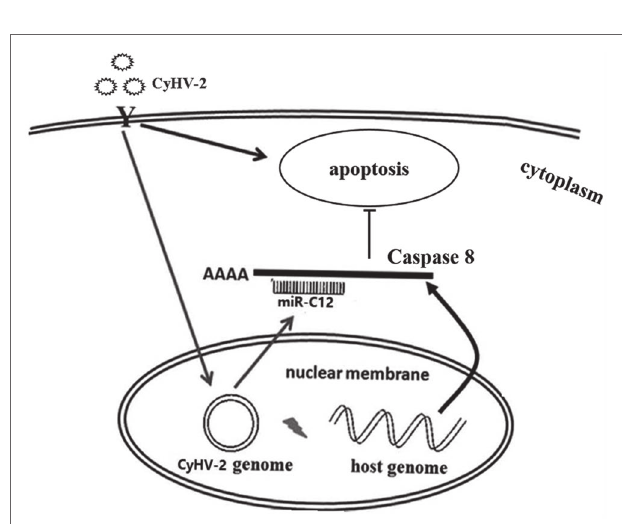
FIGURE 7 | Summary of the functions of miR-C12 in CyHV-2 infection. CyHV-2 encodes miR-C12 post infection, miR-C12 inhibits CyHV-2-induced apoptosis by targeting caspase 8 . Subsequently, the inhibition of CyHV-2- induced apoptosis led to the increase of CyHV-2